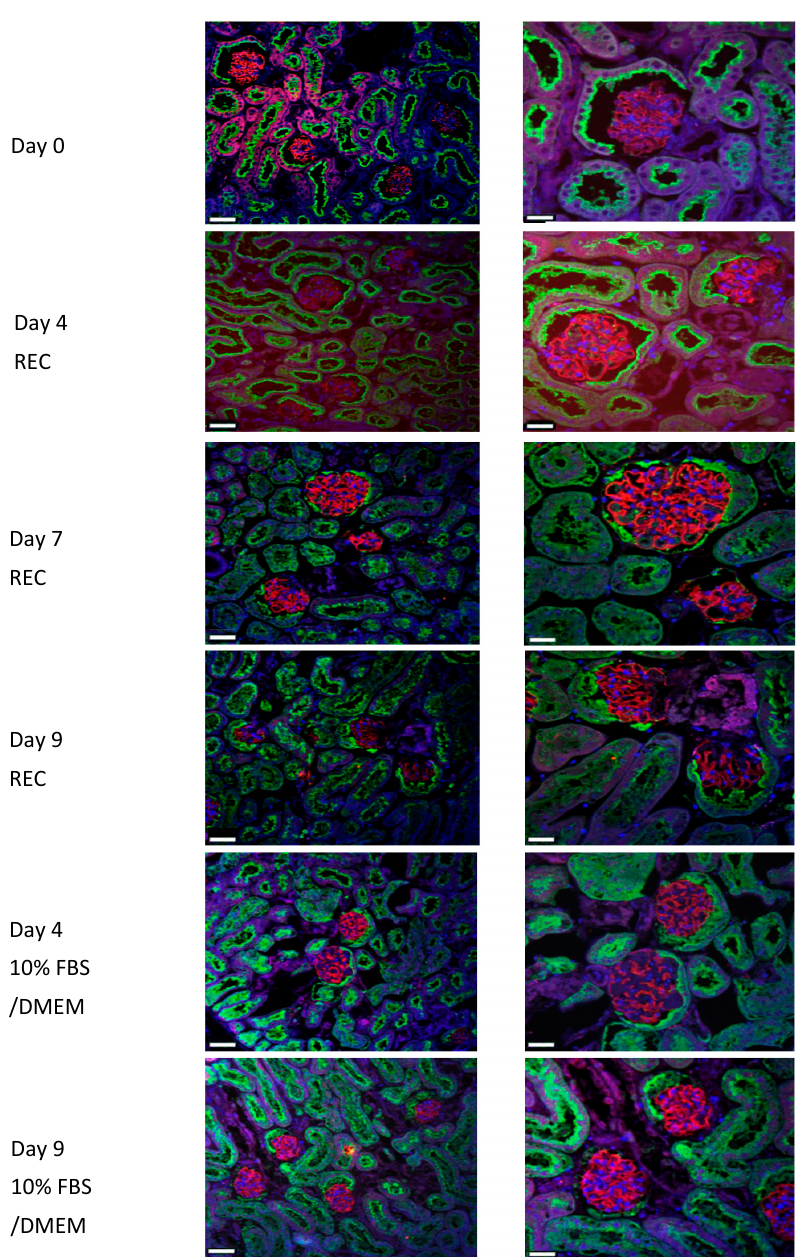
Figure 5. Intact healthy glomeruli observed in all conditions. Control kidney, cannulated but not perfused. LTL (green), Nephrin (red). LTL marks proximal tubular epithelial cells, and the parietal epithelial cells of urinary pole of the Bowman’s capsule. Nephrin depicts podocytes. Kidneys perfused with Renal Epithelial Medium for 4, 7, 9 days demonstrate normal Nephrin patterns indicating healthy glomeruli. Kidneys perfused for 4, 9 days also demonstrate Nephrin expression indicative of healthy glomeruli. Low mag bar = 45 µ m, High mag bar = 23 µ